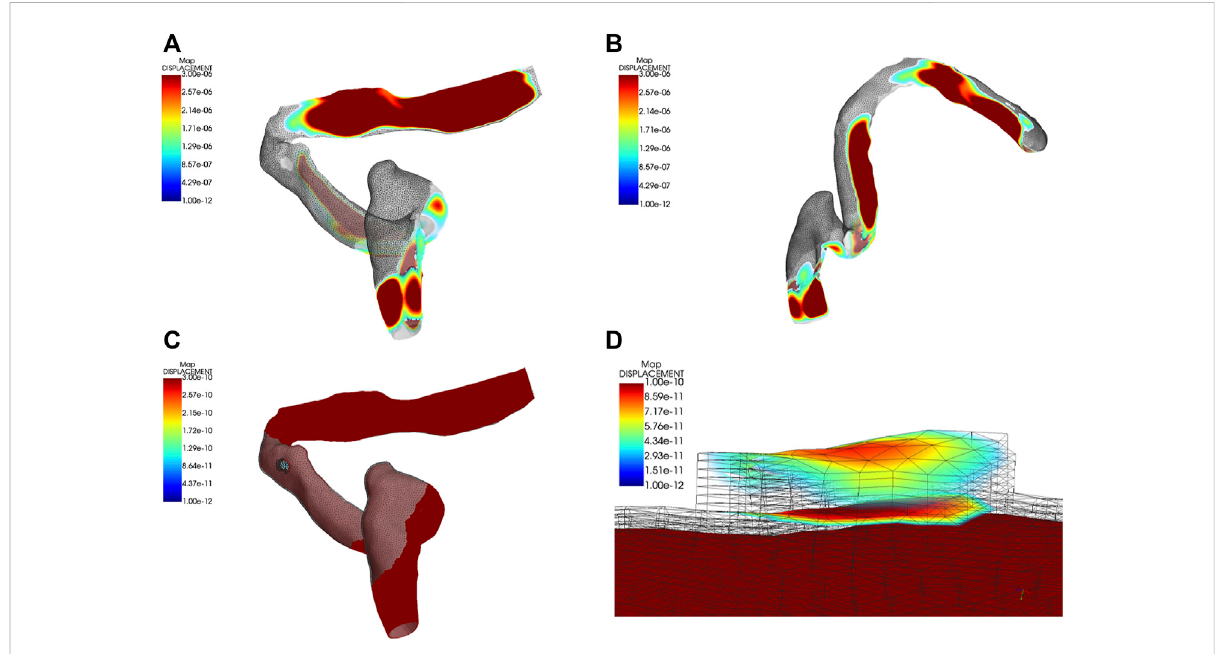
FIGURE 7 Displacement characteristics ipsilateral transverse-sigmoid sinus system. Units in graphs A to D are meters. (A) and (B) Visualization of the displacement of the ipsilateral transverse-sigmoid sinus. (C) and (D) Visualization of the dehiscent sigmoid